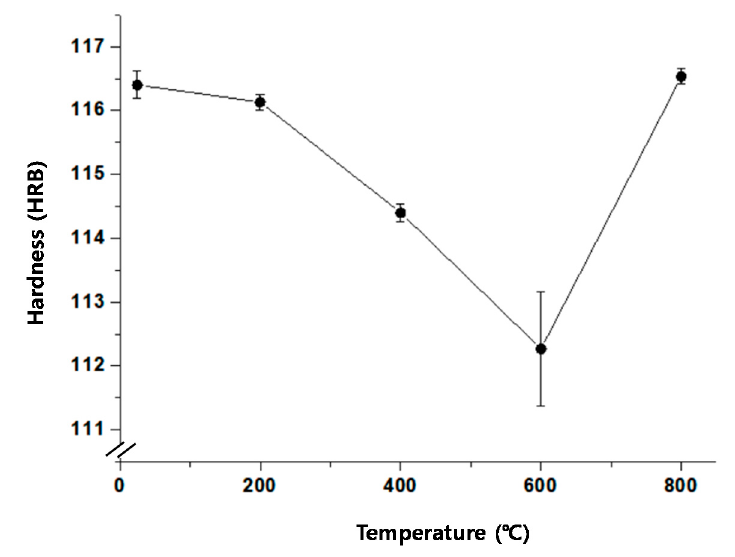
Figure 6. Hardness measurement with respect to the heat-treatment temperature.